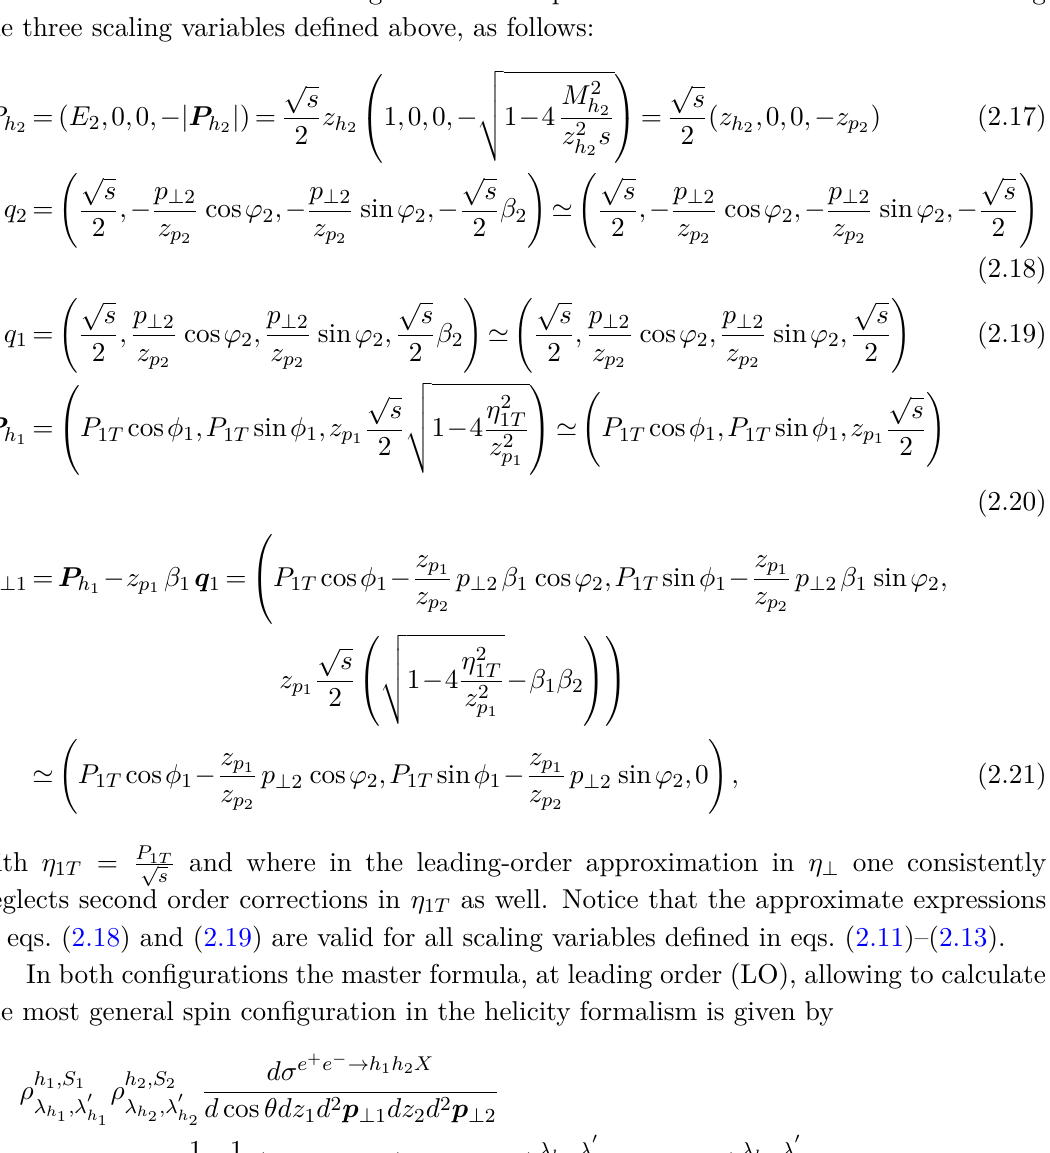
figure 2: it has the advantage that it does not require the reconstruction of the thrust